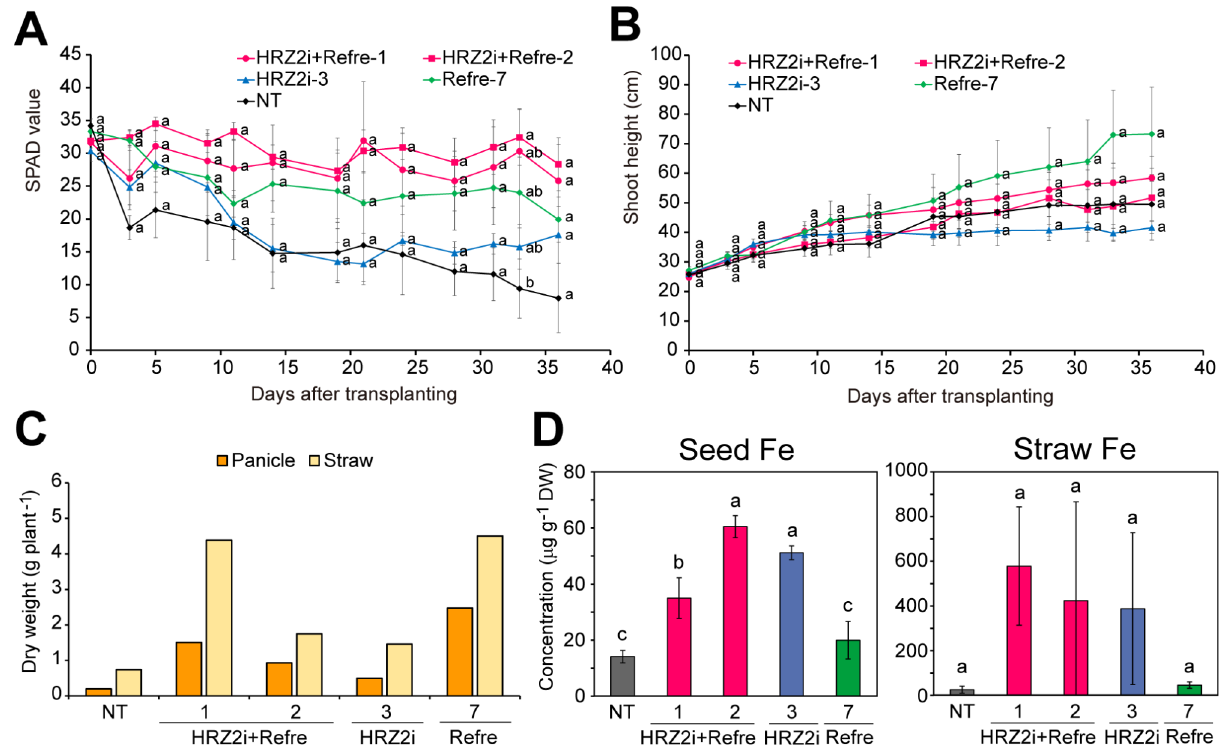
Fig. 5 Features of the HRZ2i + Refre lines compared with single transformation lines in submerged calcareous soil. A SPAD value of the newest leaves. B Shoot height. C Dry weights of panicles and straw after seed maturation. All the survived plants were collected. D Fe concentrations in the brown seeds and straw following seed maturation. The following lines were cultivated: NT, non-transformants; HRZ2i + Refre, T 1 lines of 1 and 2; HRZ2i, T 2 line 3; Refre, T 3 line 7. DW: dry weight. For A and B , the means ± SE are shown (n = 10 for HRZ2i + Refre line 2; n = 5 for other lines). For D , the means ± SD are shown (n = 3 for all lines for seed Fe and NT for straw Fe; n = 8 for HRZ2i + Refre line 2 for straw Fe; and n = 4 for other lines for straw Fe). Different letters indicate significant differences ( P < 0.05; Tukey’s honest significant difference